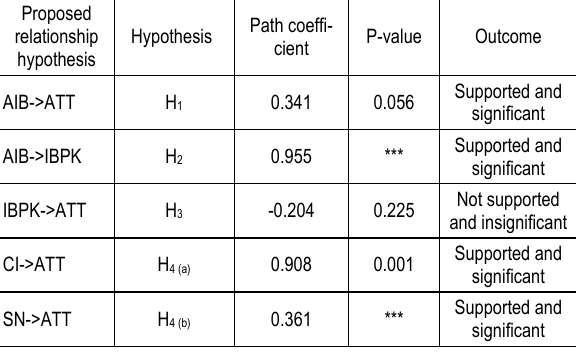
Table 5. Results of structural equation model